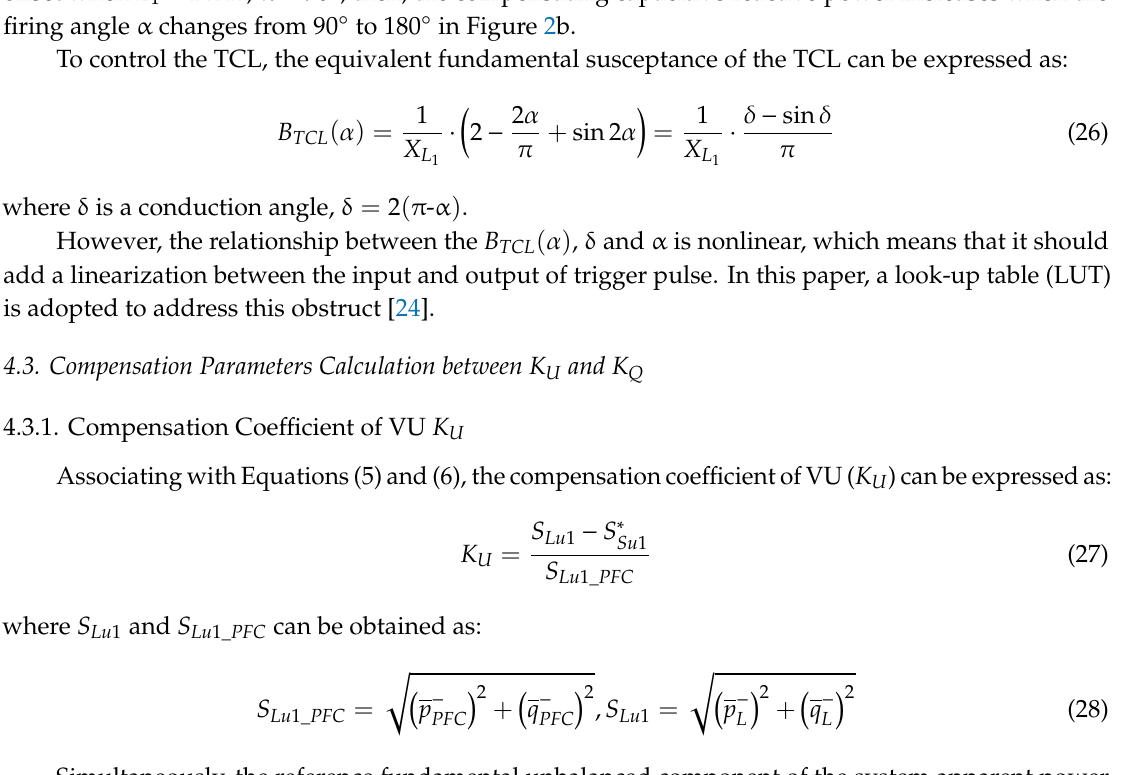
Figure 2. Relationship between the Q TCL-CTF+ , C 1 , L 1 , and α. In ( a ), the varying between the C 1 and